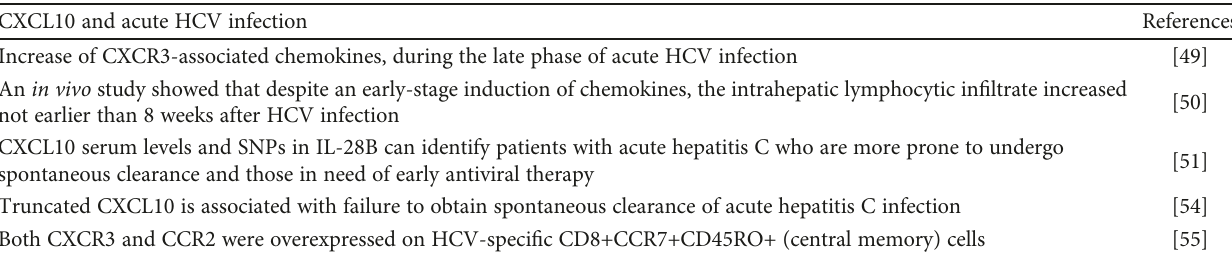
Table 1: CXCL10 and acute HCV